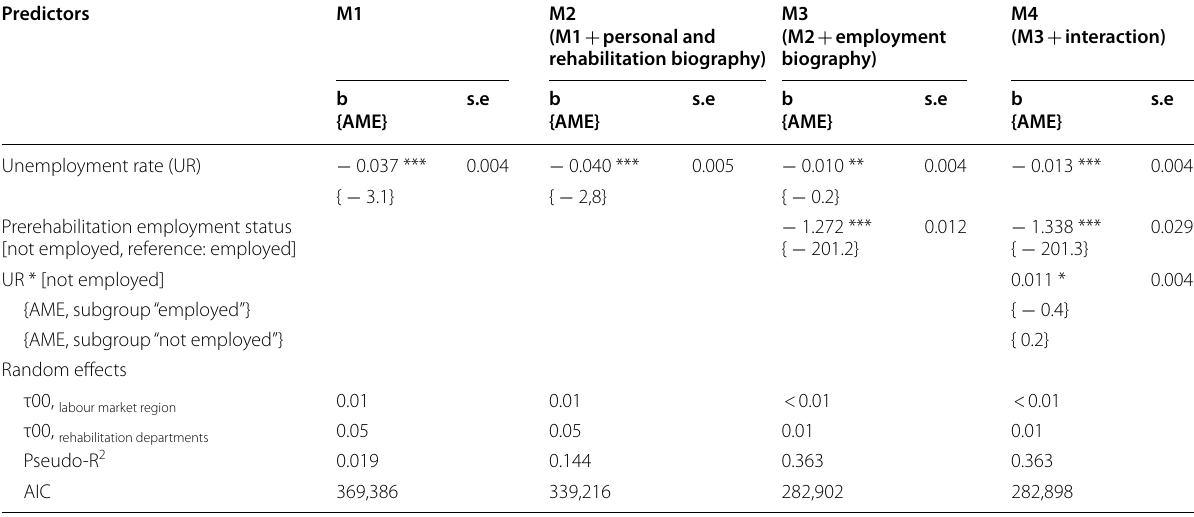
Table 3 Fractional logit regression models for RTW in orthopaedics